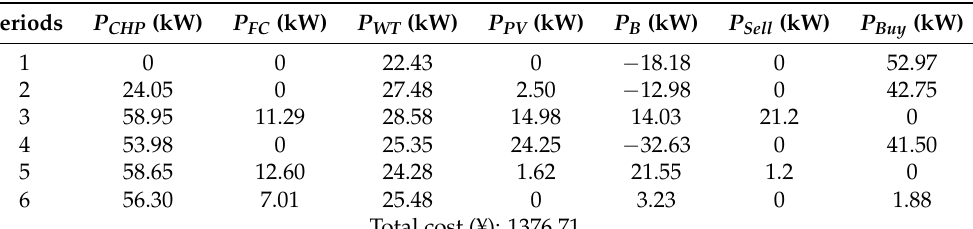
Table 5. Output power of different generators in a traditional distributed network, in which a portable energy system is installed.